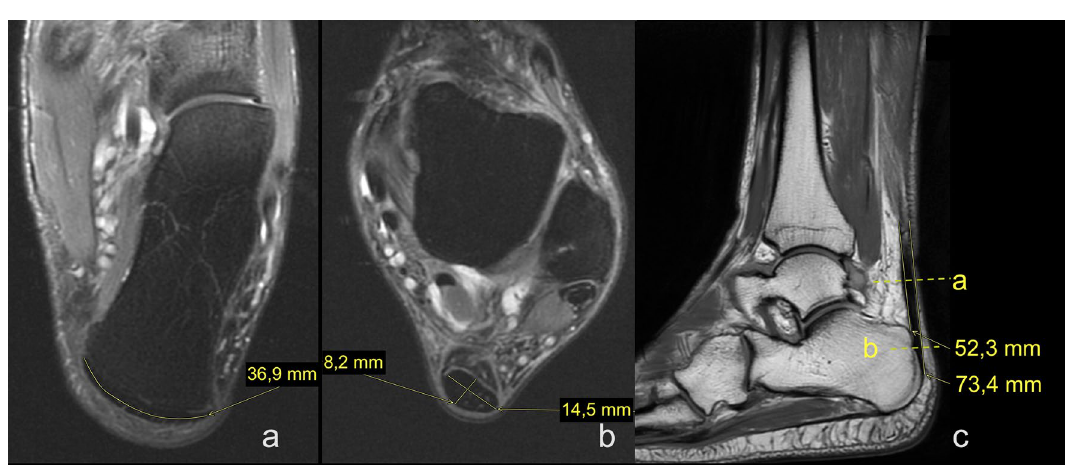
Figure 6. Diameters of the normal Achilles tendons in two patients. ( a ) and ( b ) a 34-year-old female with clinical suspicion of enthesopathy of the Achilles tendon, ( c ) a 28-year-old male with clinical suspicion of myositis. ( a ) and ( b ) axial section, PD-weighted FS, ( c ) T1-weighted.